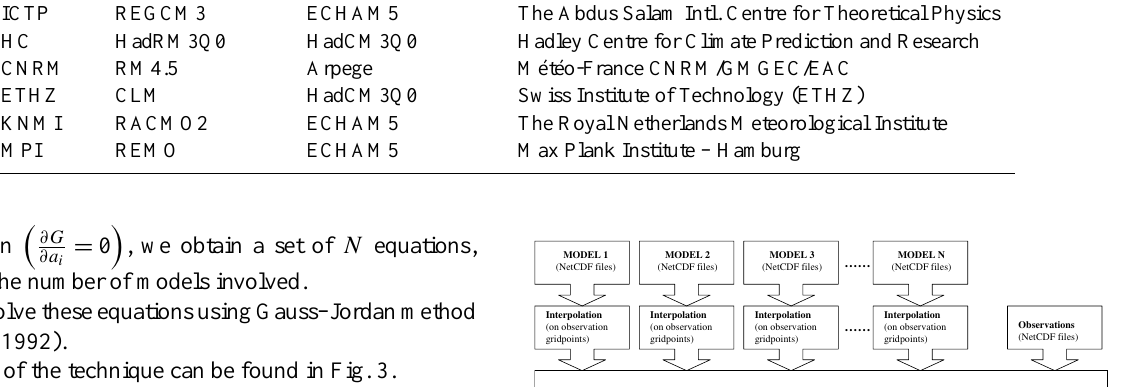
Observations (NetCDFfiles)